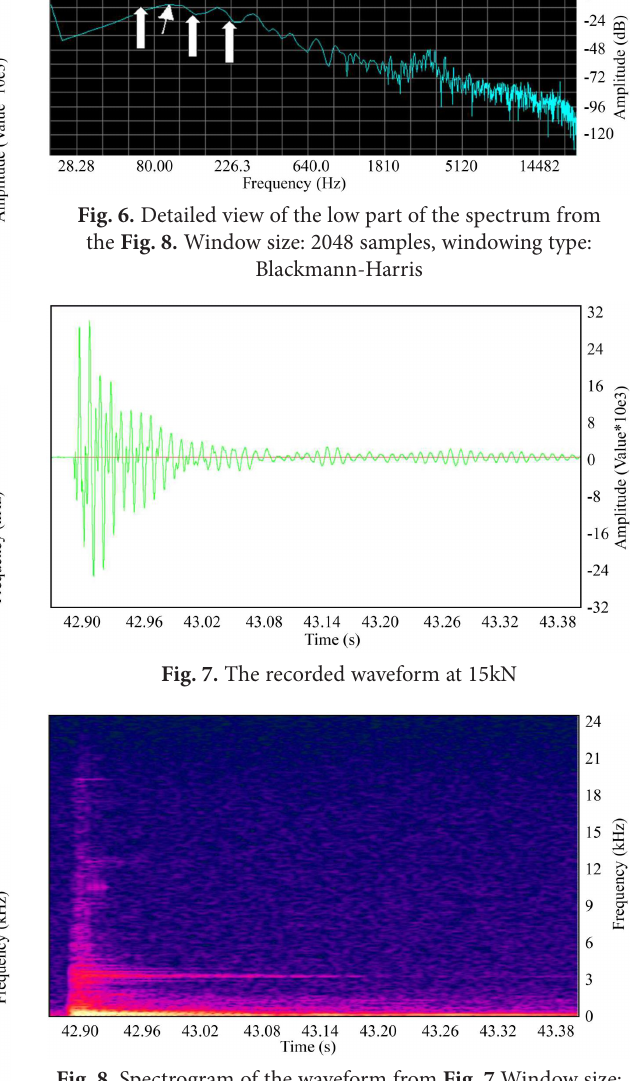
Fig. 8. Spectrogram of the waveform from Fig. 7 Window size: 512 samples, windowing type: